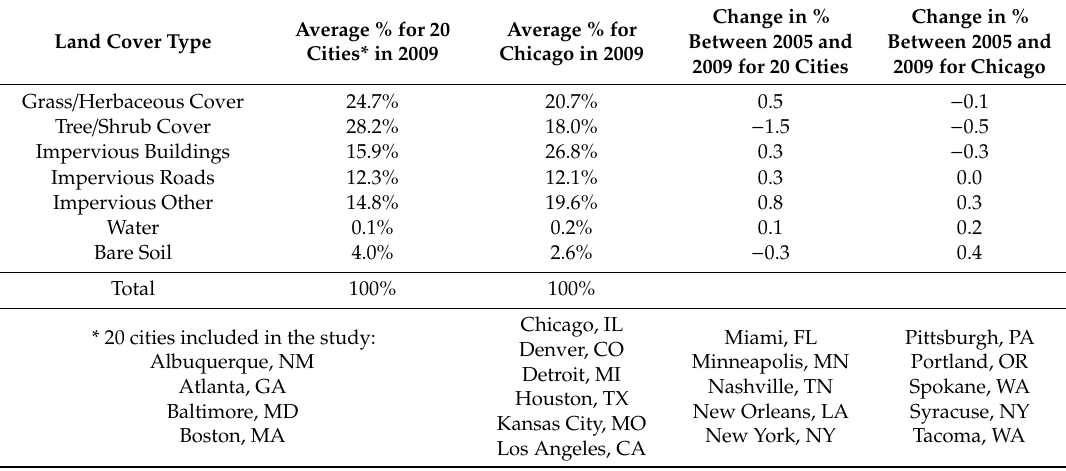
Table 3. Two-dimensional approach to quantifying urban land cover change for 20 U.S. cities* compared to Chicago from Reference